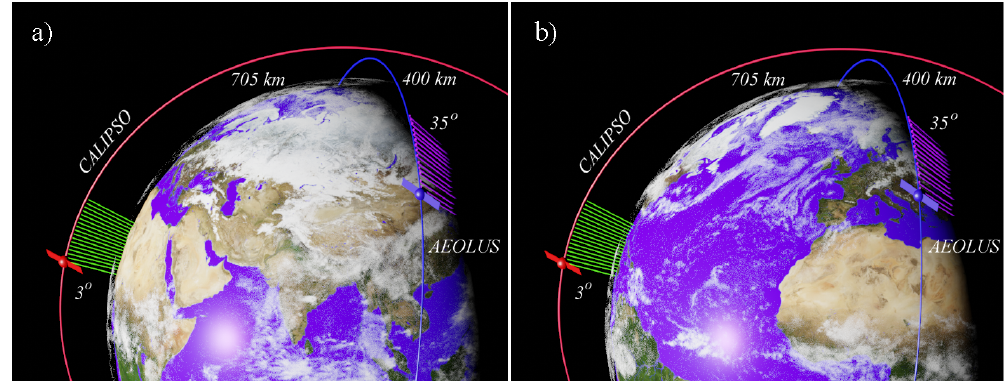
Figure 1. Observation geometry and orbits of ALADIN/Aeolus and CALIOP/CALIPSO space-borne lidars. ALADIN observes the atmo- sphere at dawn–dusk, whereas CALIOP passes the Equator at 01:30 and 13:30 local solar time. The difference between (a) and (b) is in the position of Earth and the time: in (b) , AEOLUS overflies the same area (centered over Africa) as was observed by CALIOP ∼ 4 . 5h earlier (in a ). Figure source: own visualization in Blender 2.93 software using NASA’s Earth Observatory “Blue Marble: Next Generation” collection textures. Table 1. Comparison of orbital parameters, viewing geometries, and resolutions of ALADIN and CALIOP instruments. Instrument Orbit Equator crossing Off-nadir PRF Native